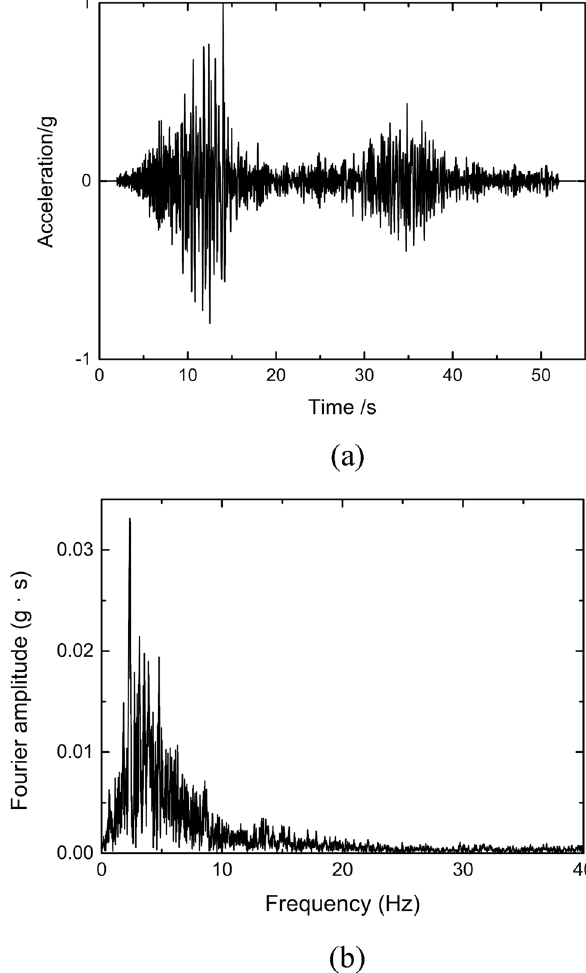
Figure 7: Seismic wave time - history and the Fourier spectrum: ( a ) Seismic wave time - history and ( b ) Fourier